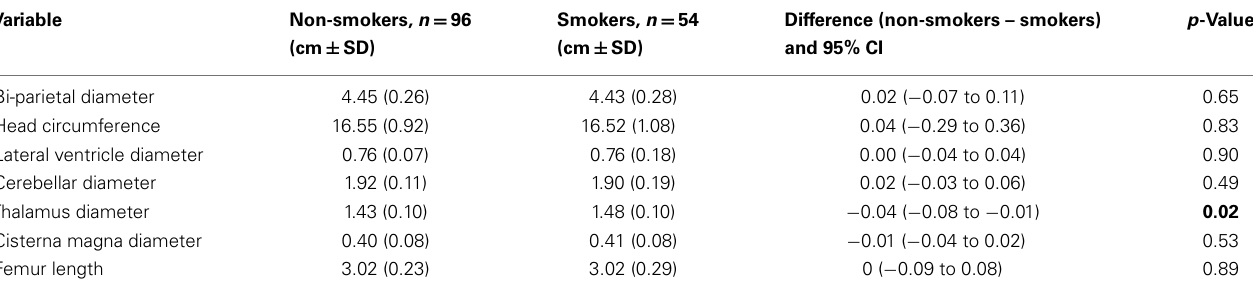
Table 3 | Comparison of FAS measurements between smokers and non-smokers .